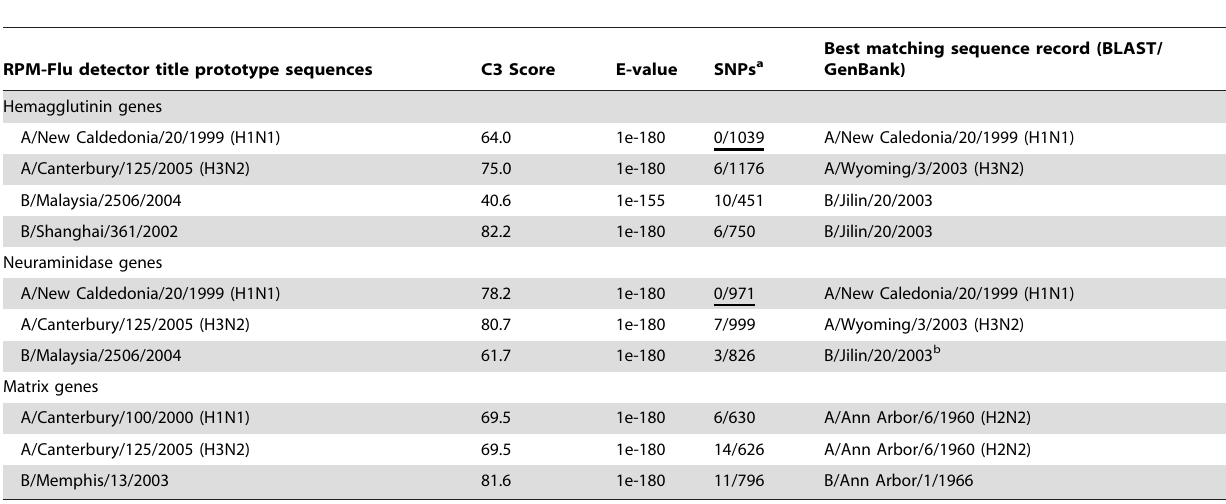
Table 1. Influenza type A and type B detector tile sequences and RPM-Flu assay-based identification of gene sequences by RPM- Flu assay of FluMist trivalent